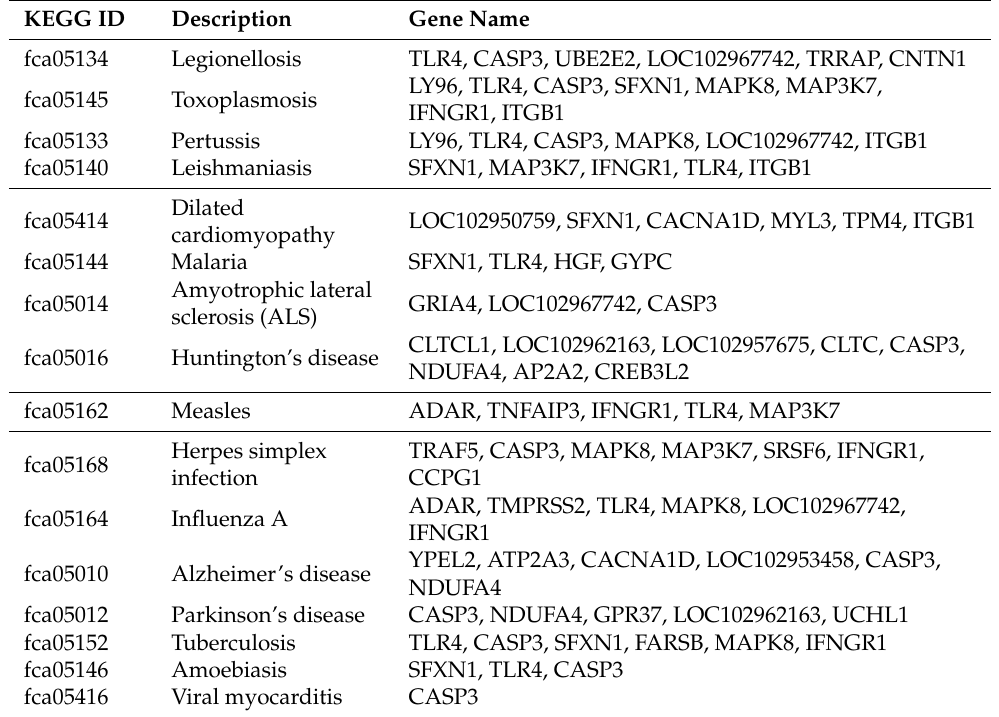
Table 3. KEGG pathway and genes related to the